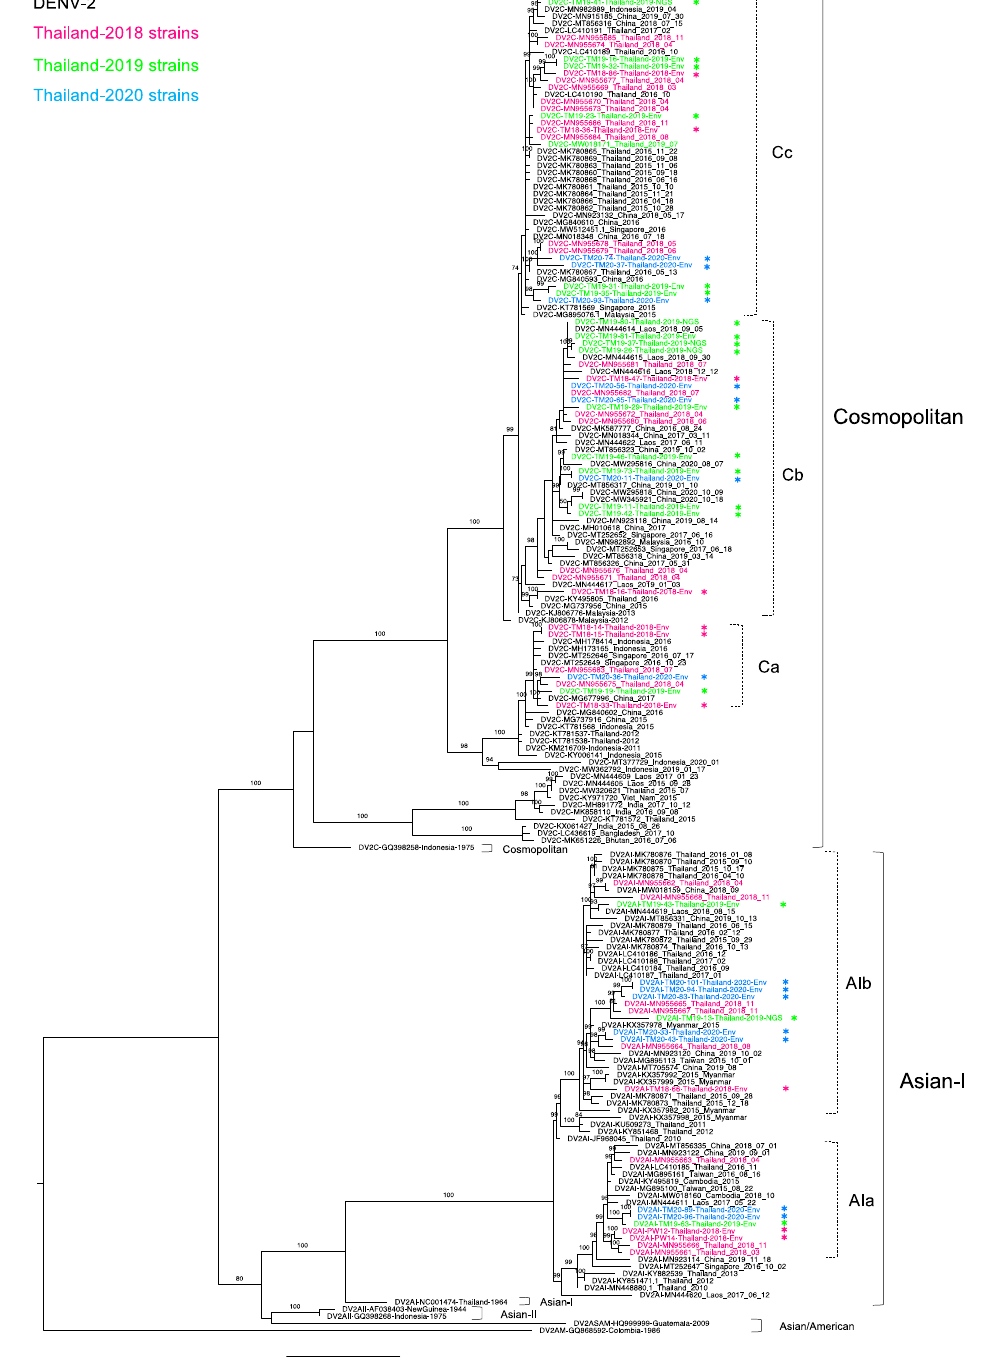
Figure 2. Phylogenetic analysis of Thailand DENV-2 in 2015–2020. The maximum-likelihood (ML) tree was constructed based on the complete envelope (E) region sequences (1485 nucleotides) under TIM2 + F + I + G4 with 1000 ultrafast bootstrap replicates. The ML tree included 44 newly determined sequences of DENV-2 from clinical specimens from Bangkok in 2018–2020, their related strains, Thailand strains during 2015–2020, and the reference genotypes. The sequences collected in 2018, 2019, and 2020 are labeled in pink, green, and blue, respectively, and indicated in the upper left corner. The sequences newly determined in the present study are marked with asterisks (*). Viral genotypes and clades are indicated by black and dotted brackets, respectively, on the right. Sequences are shown by serotype, accession number, country, and reported year. Numbers on branches are bootstrap support values exceeding 80%, except for clades Cb (73%) and Cc